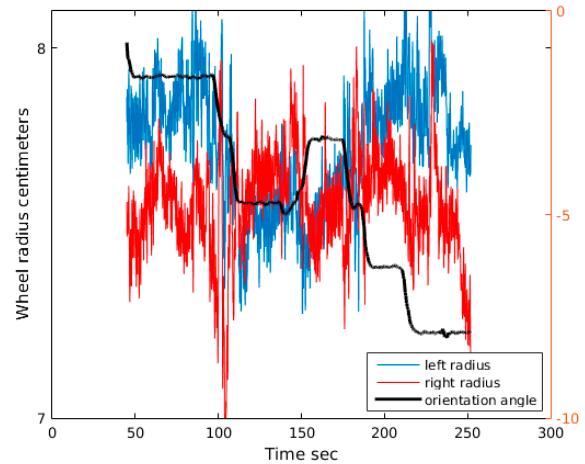
Figure 6. Wheel radius for left (blue) and right (red) wheels. In black is the orientation angle of the cart in radians.